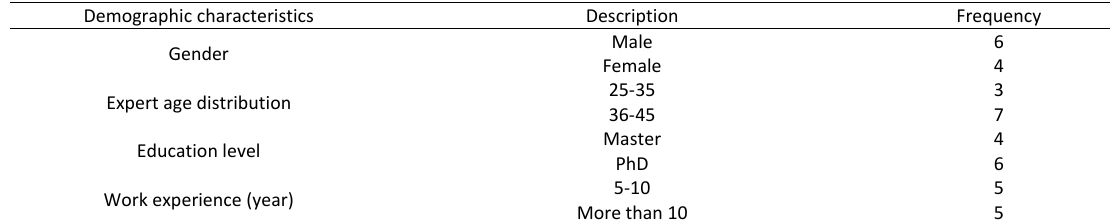
Fig. 1: The process of searching and selecting appropriate articles Table 3: Demographic characteristics of the interviewees